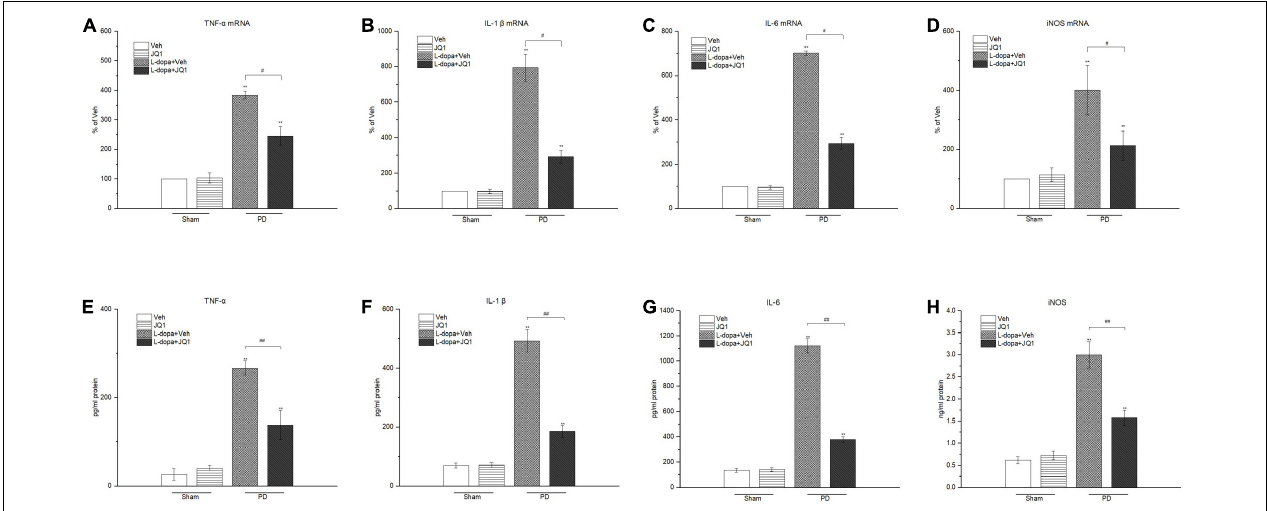
FIGURE 6 | Changes in the mRNA (A–D) and protein (E–H) levels of pro-inflammatory mediators extracted from the saline- or 6-OHDA-lesioned striatum after 21 days of administration. Both L-dopa and the L-dopa + JQ1 treatment groups showed an aberrant increase in both the mRNA and protein levels of the TNF- α , IL-1 β , IL-6, and iNOS in the 6-OHDA-lesioned striatum of rats after the 21 days of treatment ( p < 0.001 vs. Veh group). Moreover, the expression level in the L-dopa treatment group was much higher than that in the L-dopa + JQ1 treatment group ( p < 0.01). JQ1 barely affected the expression level of the four pro-inflammatory substances in the saline-lesioned striatum of the JQ1 treatment group ( p > 0.05 vs. Veh group). The data are expressed in terms of mean ± SD and as a percentage of the Veh group, ** p < 0.001 vs. Veh group; # p < 0.01 vs. L-dopa treatment group, ## p < 0.001 vs. L-dopa treatment group ( n = 4 per group for RT-PCR; n = 5 per group for ELISA).